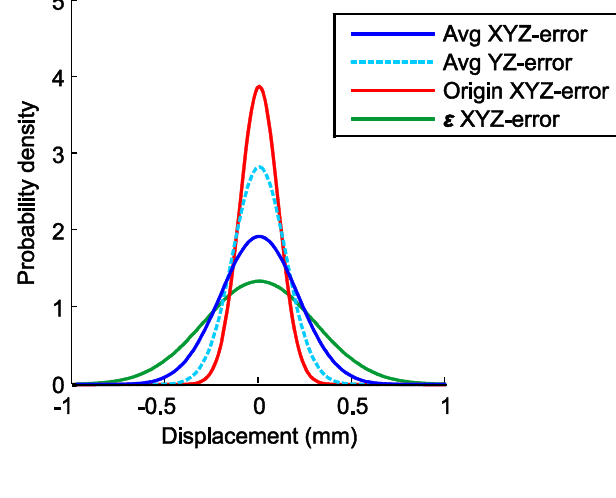
Figure 12. Normal distributions of the calculated absolute positioning errors from the UU WEC stator section positional calibration experiments, based on 400